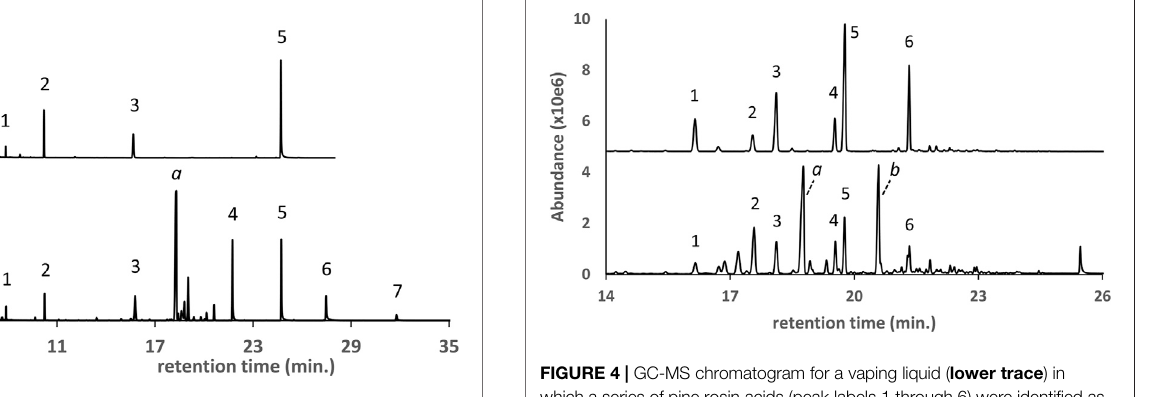
FIGURE3| GC-MSchromatogramforad9THCvapingliquid(peaklabel a, lower trace ) in which a series of polyethylene glycol oligomers (PEG oligomers, peak labels 1 through 7) were identi fi ed as the diTMS derivatives. PEG oligomer standard mix ( upper trace , condensed scale, offset) as follows: 1- tetraethylene glycol; 2- pentaethylene glycol; 3- hexaethylene glycol; 5- octaethylene glycol.